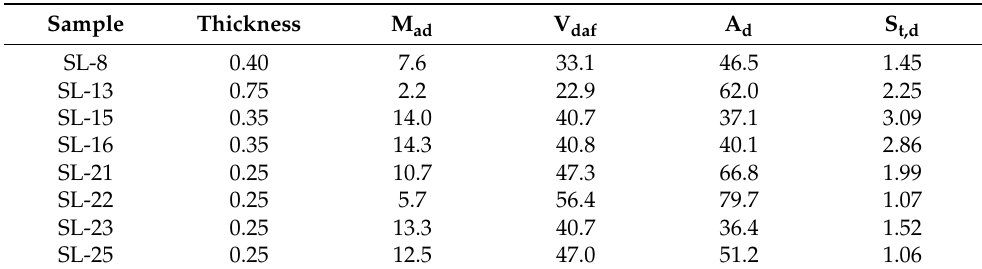
Table 1. Thickness (m), proximate analysis (wt.%), and sulfur content (%) of the coal samples from the outcrop profile in the Xian’an